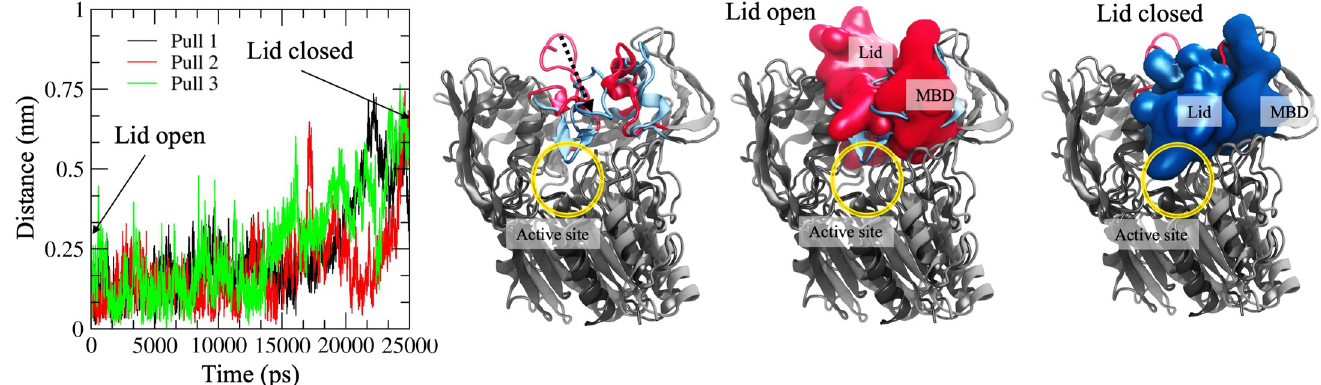
Fig 6. (Left) Steered molecular dynamics analysis showing the distance of the α -carbon atom of MET66 from the initial position as a function of time. (Right) Superimposed snapshots illustrating the pulling pathway of the lid loop. The light red and blue cartoon or van der Waals renderings mark the lid loop’s open and closed states, respectively. The rest of the LCAT enzyme is rendered as a grey cartoon representation. The black arrow indicates the movement of the lid loop during the pulling simulations. The active site tunnel opening is marked with a yellow sphere.